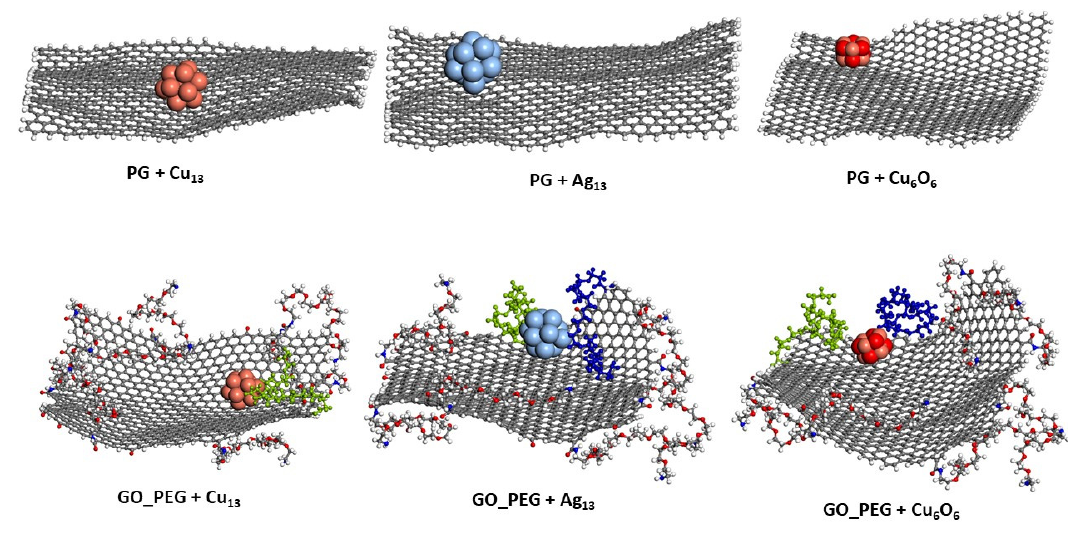
Figure 4. Representative position of the nanoclusters for pristine and functionalized graphene monolayers after 10 ns of simulation length. The PEG chains closest to the nanoparticles are shown in blue and green.